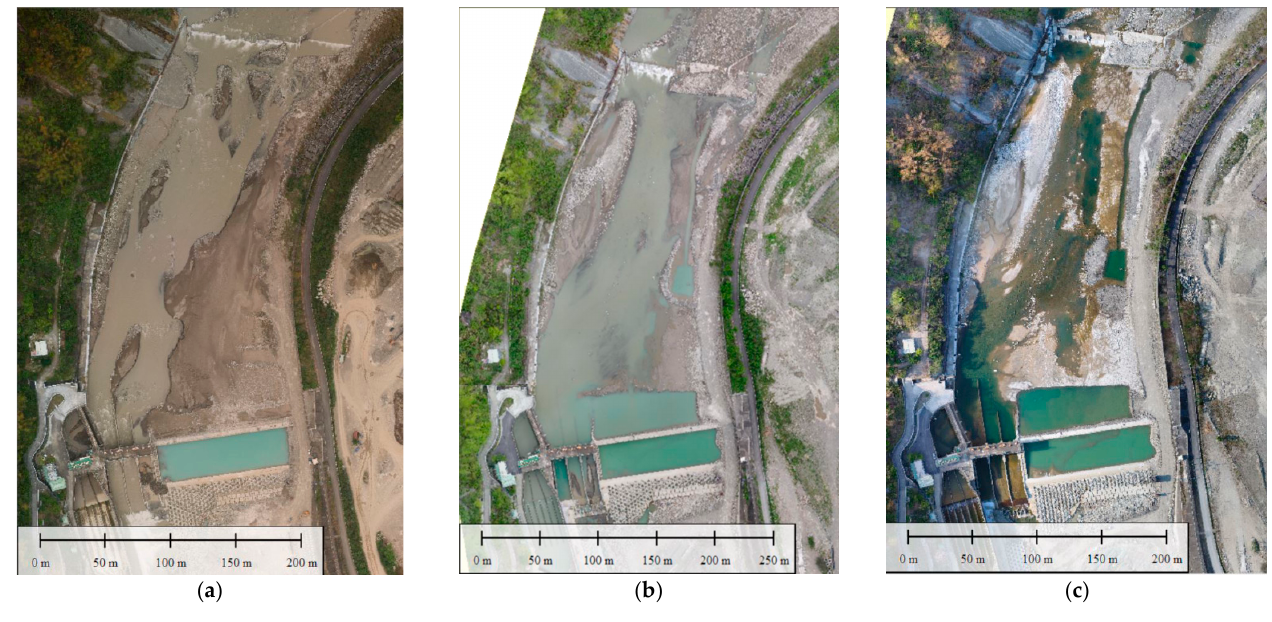
Figure 7. Three orthophotos of the study area taken on ( a ) 6 April 2016, ( b ) 10 April 2017, and ( c ) 22 May 2017.